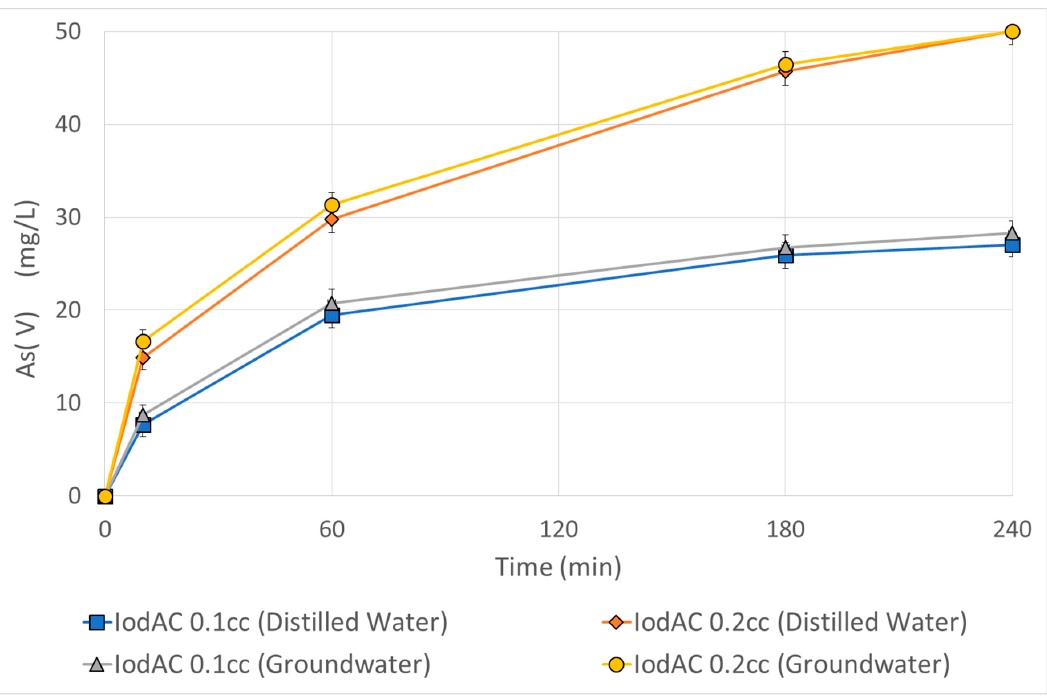
Figure 2. Kinetics of the arsenite (50 mg/L) oxidation batch test in distilled water and groundwater using IodAC(30).